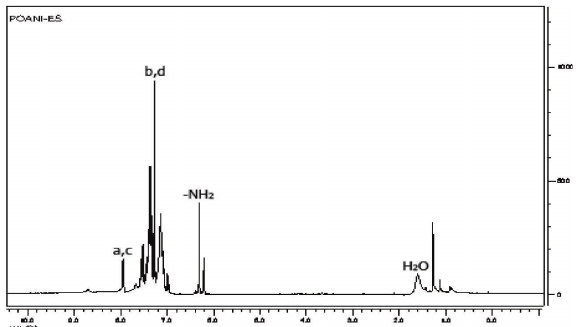
Figure 3: 1 H NMR spectrum (300 MHz, CDCl 3 , tetramethylsilane (TMS) were used as the internal standard) of polyaniline (PANI-ES) obtained by the polymerization of aniline with Mag-H + initiator system in CDCl 3 at 0 ◦ C.